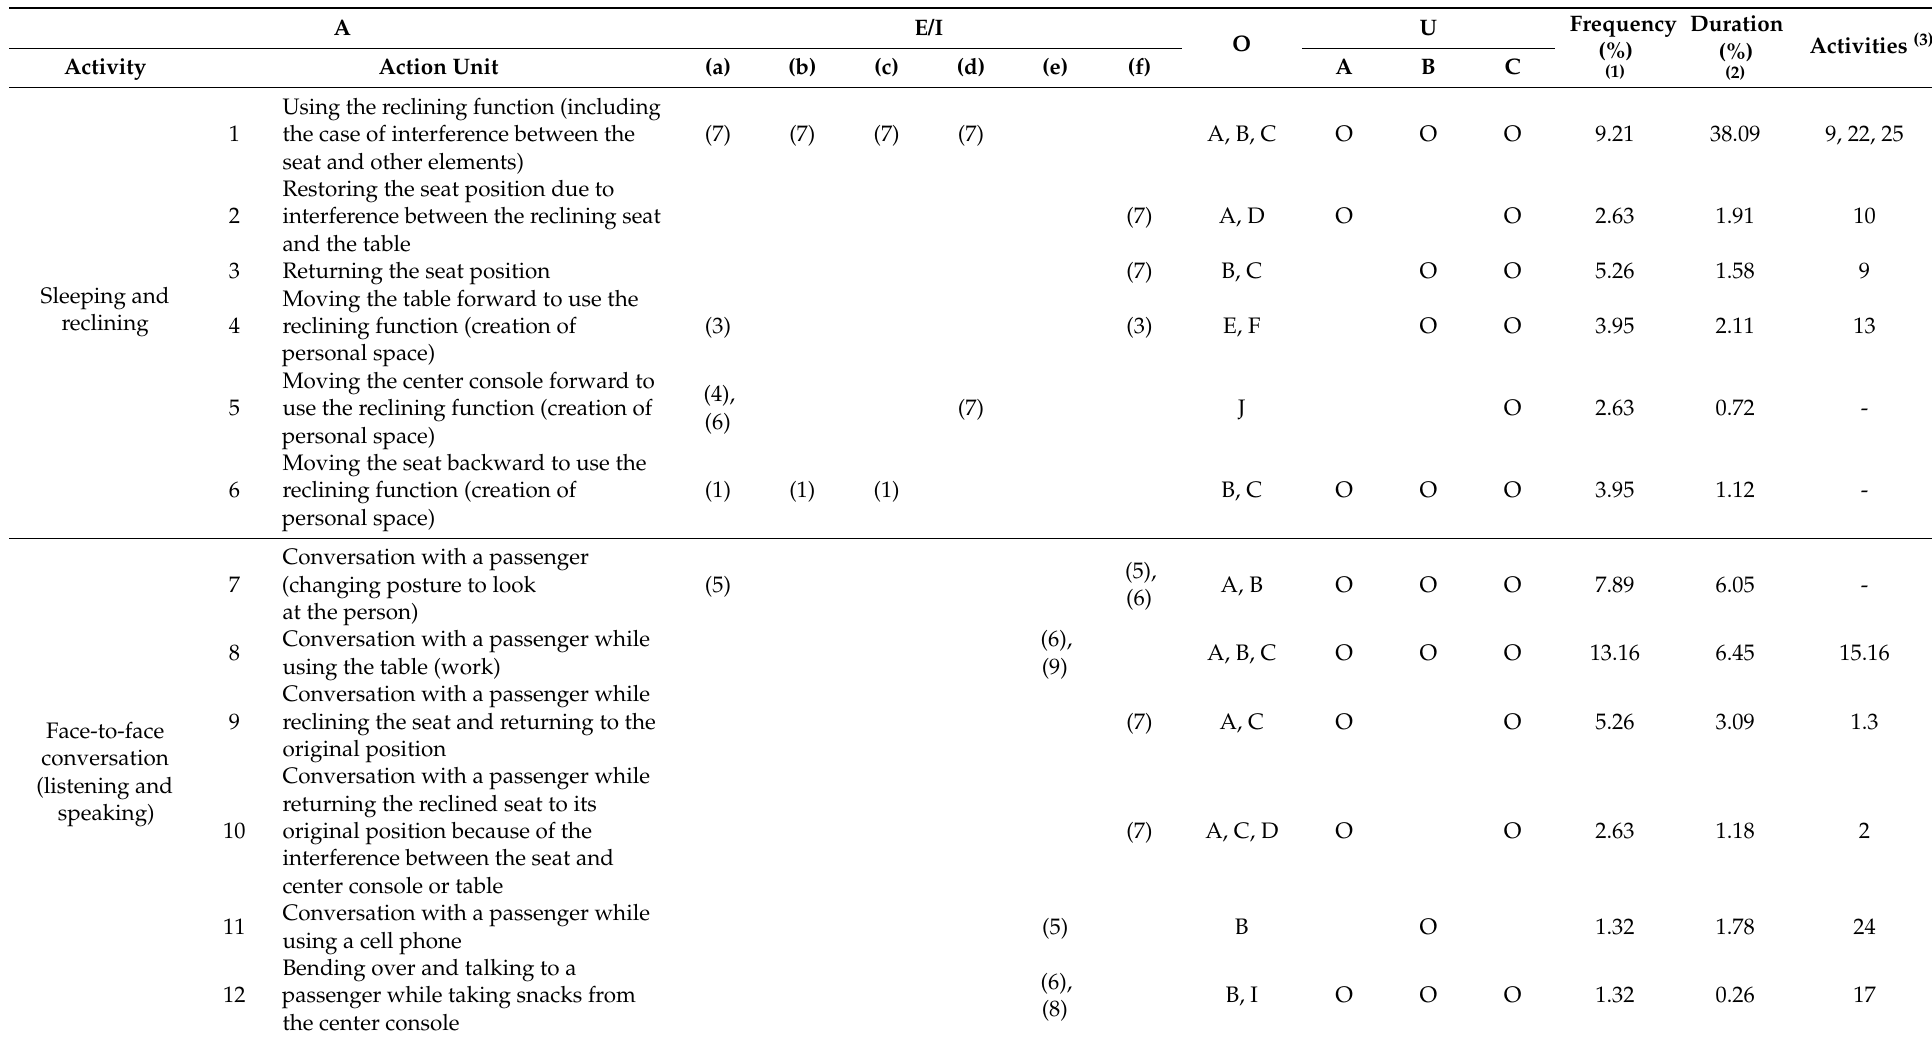
Table 7. Analysis of “action” unit characteristics by “activity” unit ( (1) ratio of frequency (%), (2) ratio of time duration (%), (3) the number of activities that took place concurrently, (4) in the case of table-use activity, the task of completing the questionnaire is performed, and thus, it is excluded from the analysis of the ratio of frequency and ratio of